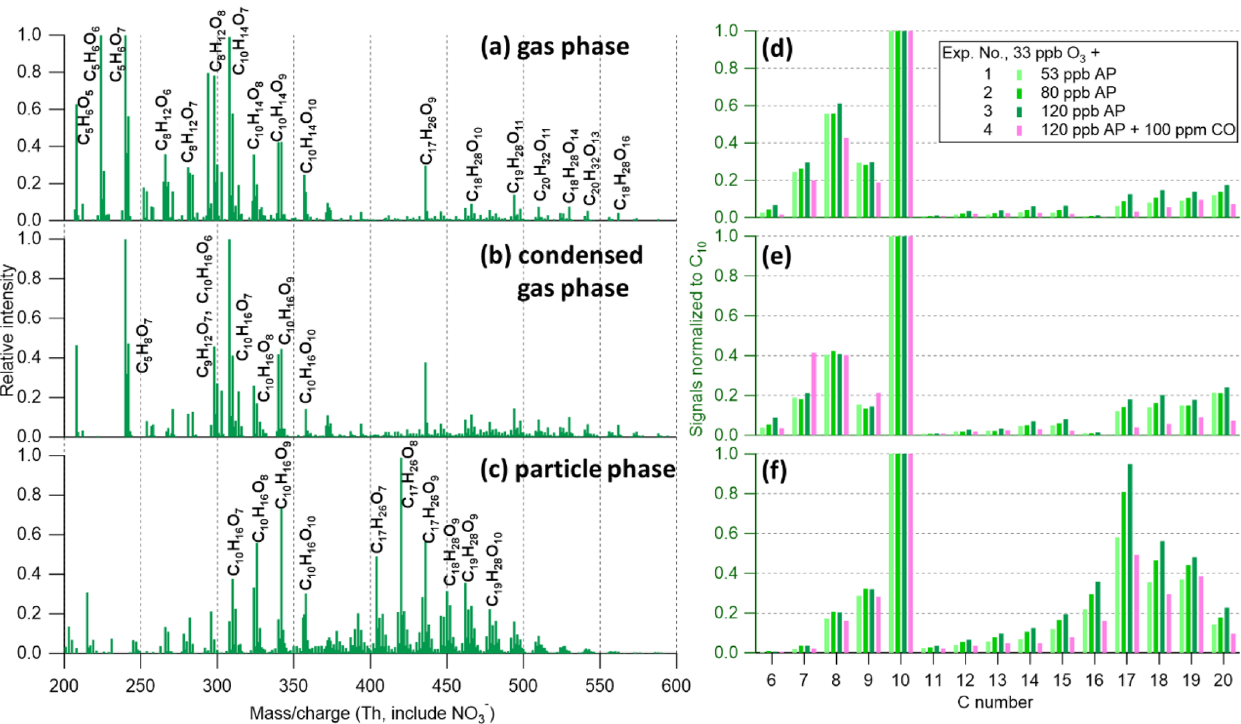
Figure 4. (a–c) Mass spectra of (a) gas-phase (without seed particles), (b) condensed-gas-phase (from the difference between gas-phase mass spectra without and with seed particles, see Sect. 2.2), and (c) particle-phase (at 230 ◦ C) measurements from experiment no. 3 (input flow concentration as 120ppb α -pinene and 33ppb O 3 ). Gas-phase and condensed-gas-phase mass spectra (30min average) are normalized to (C 10 H 14 O 7 )NO 3 at m/z 308 with m/z 224 and m/z 240 off the scale. Particle-phase mass spectra (60min average) are normalized to (C 17 H 26 O 8 )NO 3 at m/z 420. (d–f) The distribution of HOM products for experiment nos. 1–4, grouped by C numbers, is summarized